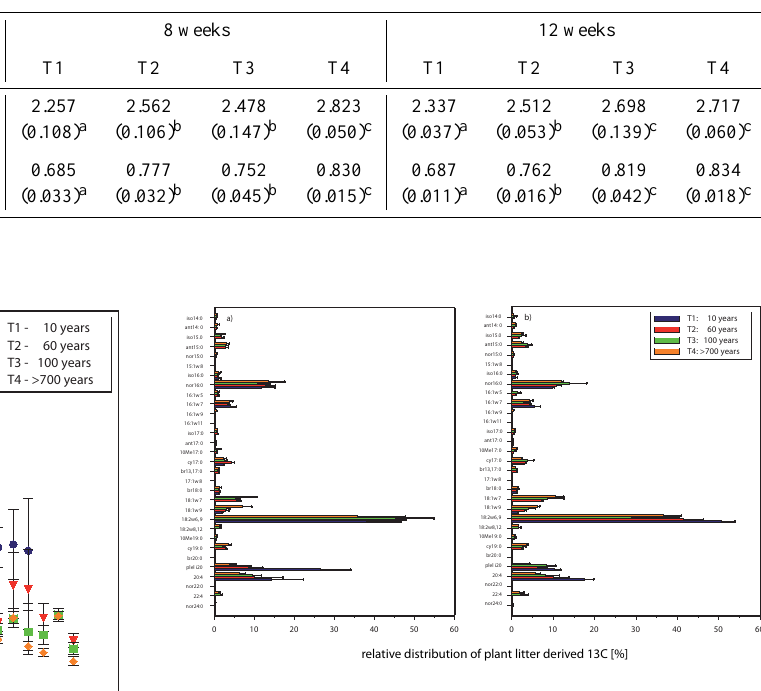
Fig. 4. Distribution of 13 C derived from litter (in % relative to total litter derived 13 C into total PL according to Fig. 1; means + standard deviation; n = 5) within phospholipids in soil samples after 8 weeks (a) and 12 weeks (b) of litter incubation at different locations T1– T4. were also assessed by means of PCA analysis (Fig. 5). Prin- cipal components accounted for 59.7 % (PC1) and 16.5 % (PC2) of the total variance, respectively. Results showed